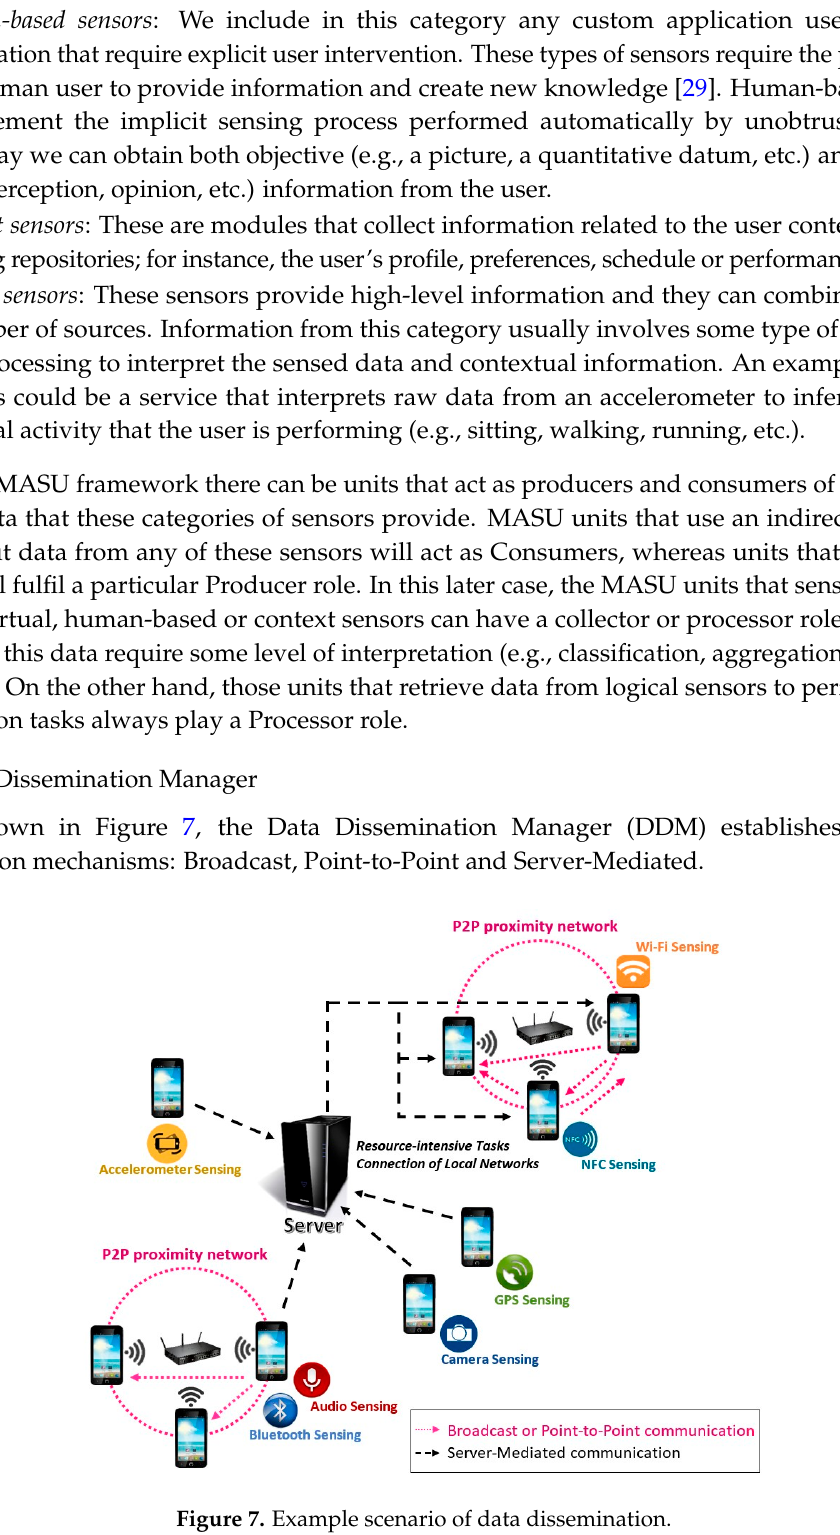
Figure 7. Example scenario of data dissemination.